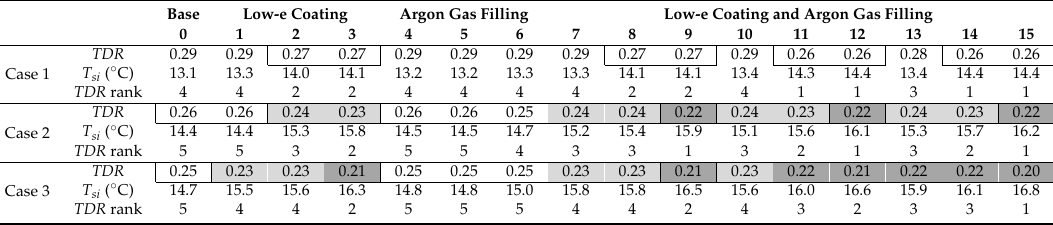
Table 8. TDR s and indoor surface temperatures at the glazing edge (E1 in Figure 7a). Base Low-e Coating Argon Gas Filling